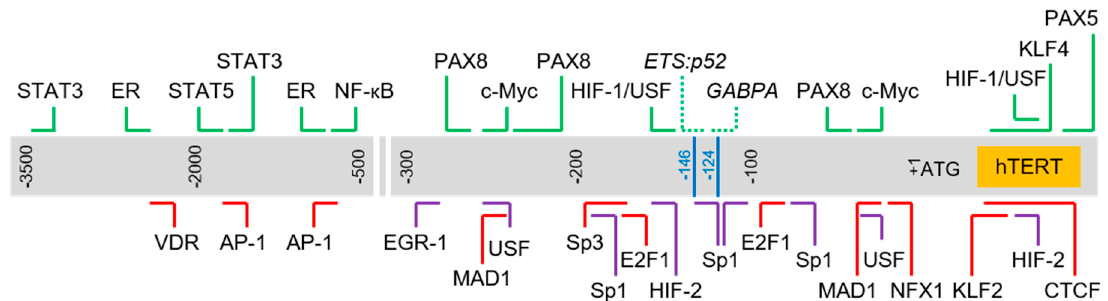
Figure 1. Schematic of transcription factor binding sites in human Telomerase Reverse Transcriptase ( hTERT) promoter. Chromosomal sequence extending from 3.5 kb upstream and 150 bp downstream of hTERT translation start site (+1) is represented by the gray box. Horizontal lines above and below the box indicate approximate binding sites of respective transcription factors. Blue lines: hotspot promoter mutations (“-124” corresponds to C228T mutation; “-146” corresponds to C250T mutation); green: activator; red: repressor; purple: regulator with dual roles; dotted line: regulator bound to sites created by hotspot mutations.